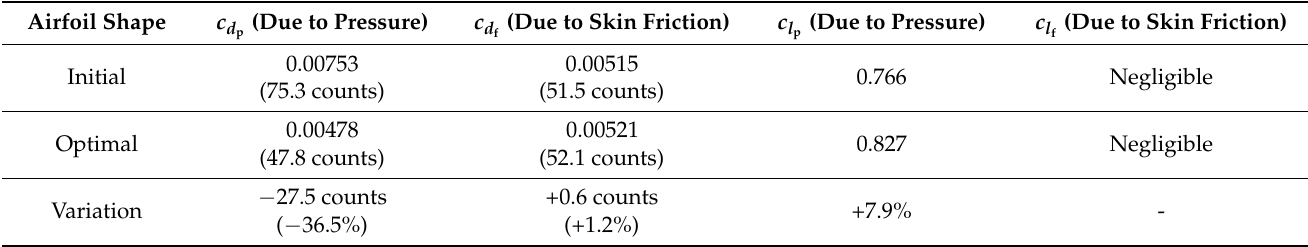
( a ) Gradient of objective function ( b ) Objective function history Figure 14. The gradient of the objective function with respect to the design variables ( a ) and the history of the objective function during the shape optimization process (Test case I). Table 2. The value of the components of the drag (drag due to pressure and drag due to skin friction) for the initial and optimal shapes (Test case I).